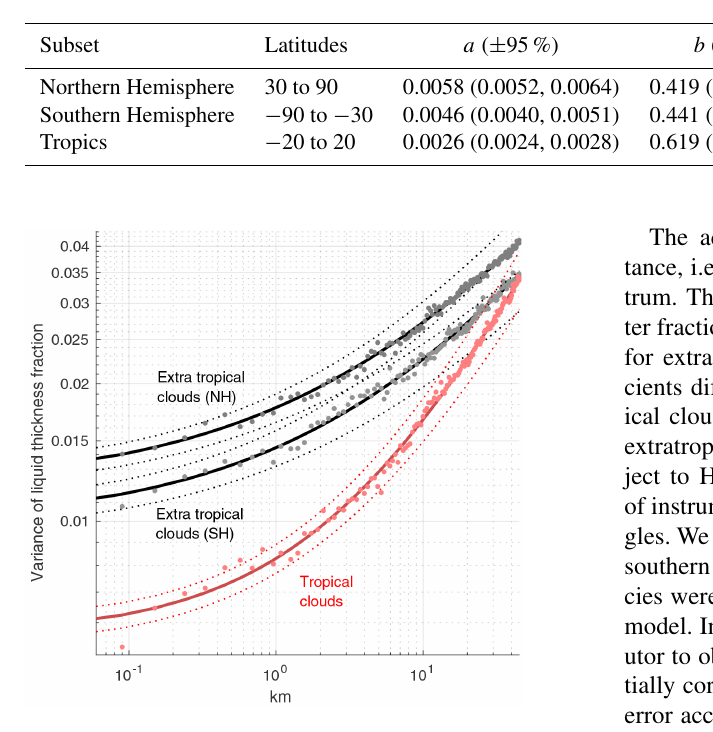
Figure 9. Variogram for all clouds in the Hyperion dataset, showing the variance as a function of separation between points. The curve suggests a power law relationship. Dotted lines indicate 95% con- fidence intervals on the